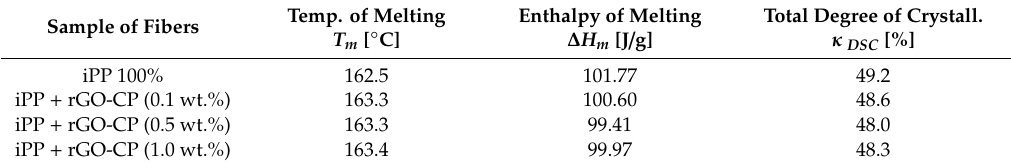
Table 5. Parameters determined based on DSC measurements for fibers taken at 800 m / min. Sample of